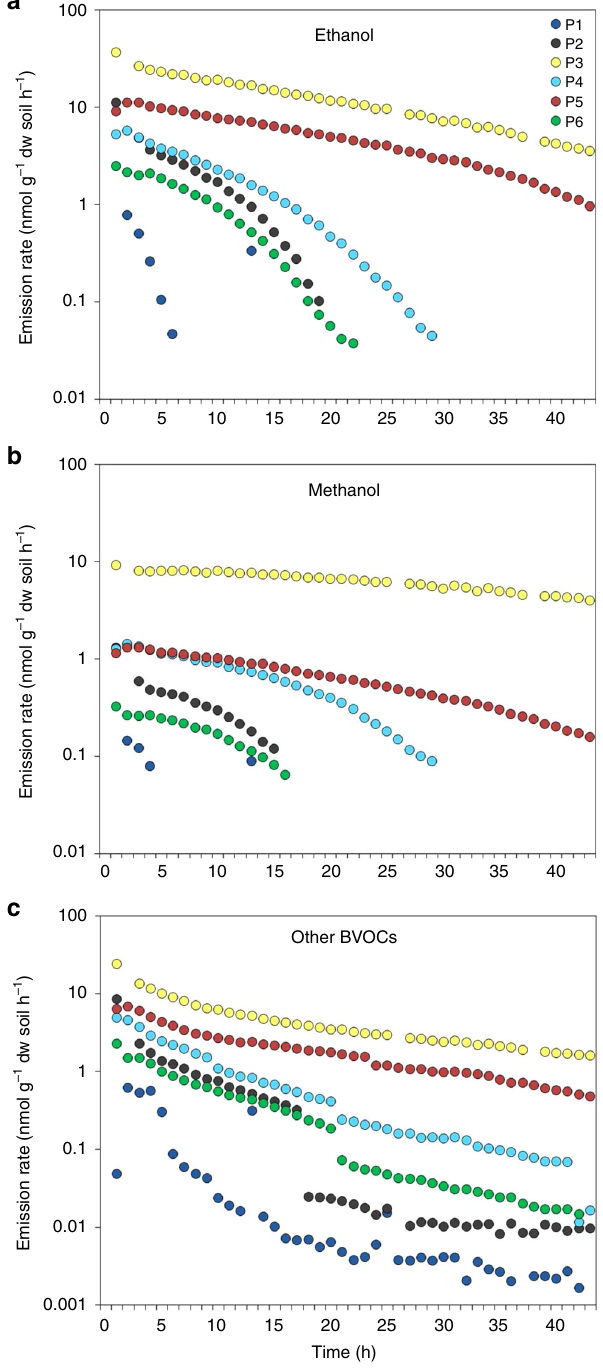
Fig. 1 Release of volatiles from thawing permafrost soils. The release of a ethanol, b methanol, and c other biogenic volatile organic compounds (BVOCs) over 43 h is shown for six permafrost soils (P1 – P6) collected on Disko Island, Greenland. dw dry weight compounds positively correlated with the dissolved organic carbon (DOC) and ammonium concentrations as well as the water content of permafrost (Fig. 2, Supplementary Fig. 2, 3). The variables showing strongest negative correlations with the emission rates were pH, microbial biomass, and water- extractable dissolved phosphorus concentration. Also total dissolved nitrogen and nitrate concentrations correlated NATURE COMMUNICATIONS| (2018) 9:3412 |DOI: